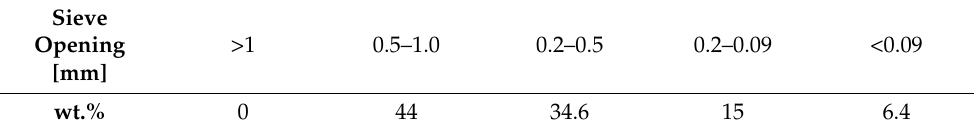
Table 3. Particle size distribution of MOTIM mullite, 0–1 fraction.